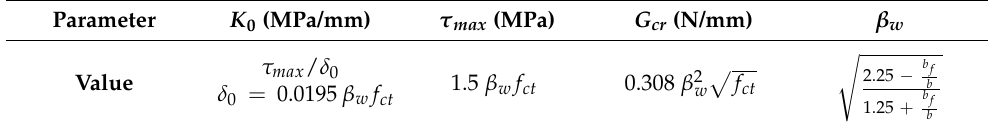
Table 2. Parameters of bond-slip model used in the FE study.